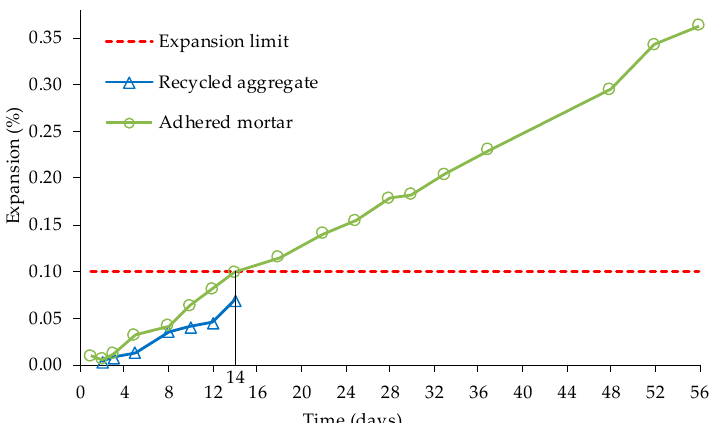
Figure 8. Expansion of recycled aggregate and adhered mortar after 14 days and after 56 days in ASTM C 1260, adapted from [80].